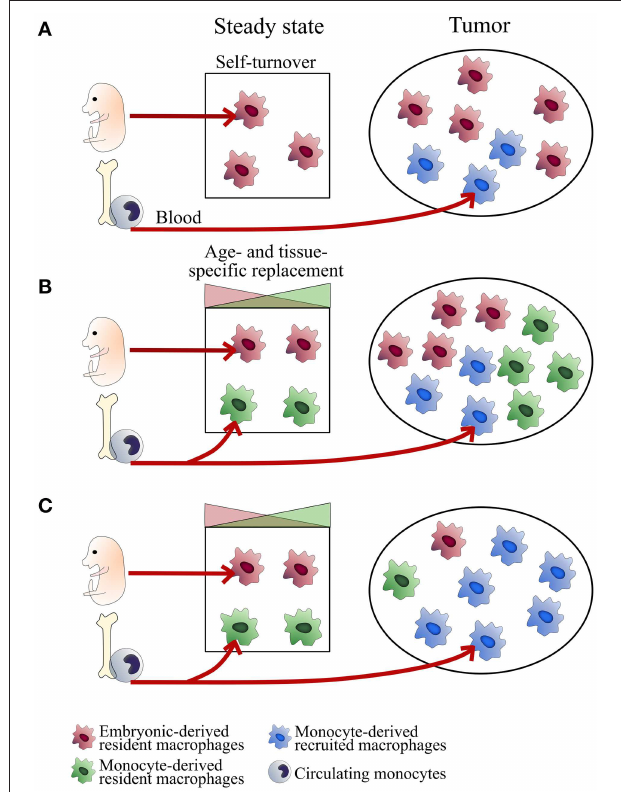
FIGURE 1 | Tissue-dependent heterogeneity of TAM origin. Schemes represent different scenarios of TAM ontogeny. TAM composition may depend on the regulation of macrophage self-maintenance and turnover. This regulation is tissue- and subset-specific. In some tissues, embryonic-derived resident macrophages self-maintain over time (typically microglial cells in the brain, alveolar macrophages in the lungs; Scenario A ). Other subsets are progressively replaced by monocyte-derived macrophages with turnover rates depending on the subtissular niches (typically, rapid turnover for certain macrophages of the gut or the dermis and slow turnover for interstitial macrophages of the lung, heart and pancreas; Scenario B ). At tumor onset, classical monocytes are recruited to the tumor (mainly in a CCR2-dependent manner) and differentiate into inflammatory TAM (MoD-TAM). Depending on tumor localization and the inflammatory state, ResMac proliferate (scenarios A and B ) or not (scenario C ) and contribute more or less to the pool of TAM (ResTAM), exerting distinct functions in tumor development. Scenarios (A,B) are expected in brain and lung tumors respectively. The use of inflammatory ectopic tumor models may bias toward scenario (C)